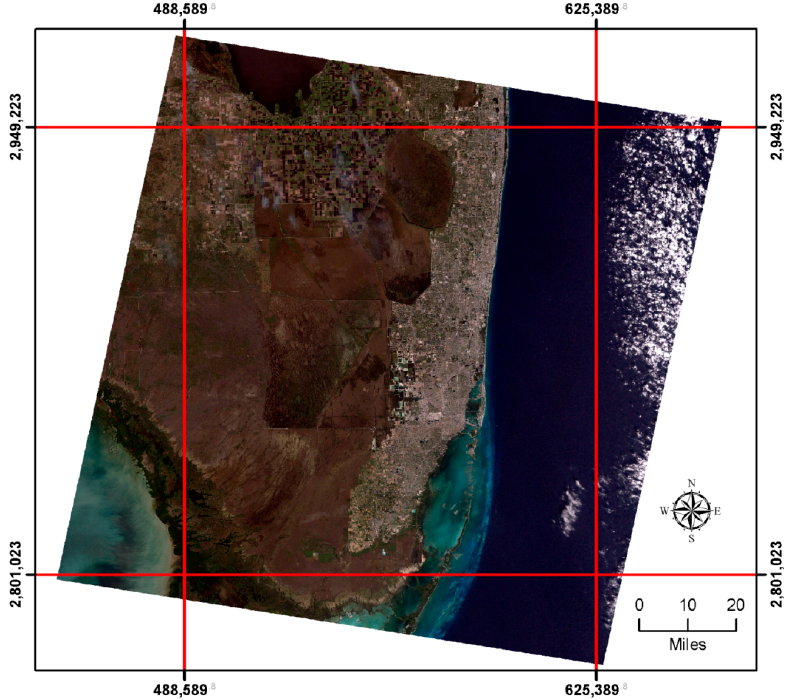
Figure 1. A composite of the Florida Everglades remotely-sensed image respectively using bands B1, B2, and B3 for red, green, and blue colors. The red lines demarcate the study area.